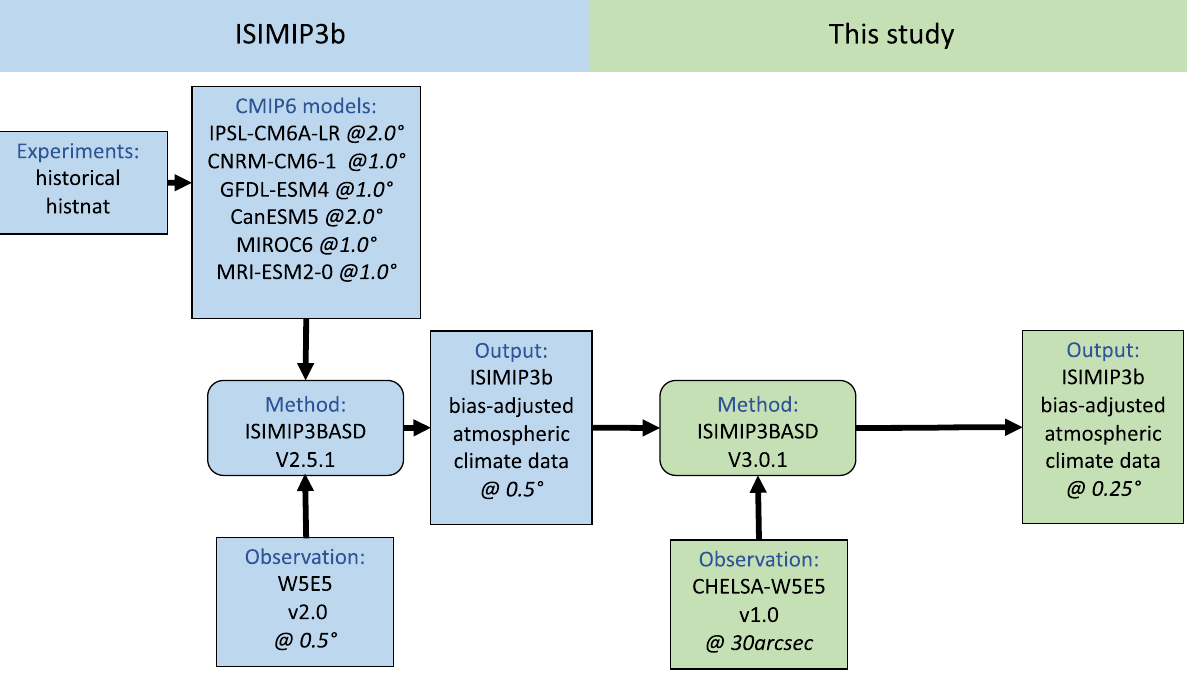
Figure 2. Schematic of the ISIMIP3b (blue) and this study’s approach (green). Boxes with sharp (rounded) corners represent data (algorithms). The spatial resolution of different data sets is indicated in